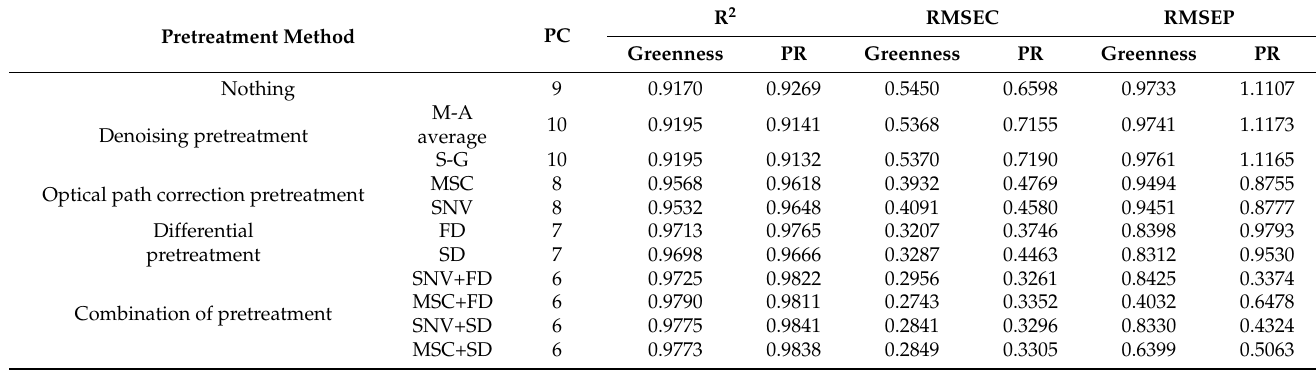
Table 2. Statistics of the data preprocessing methods for the number of principal components